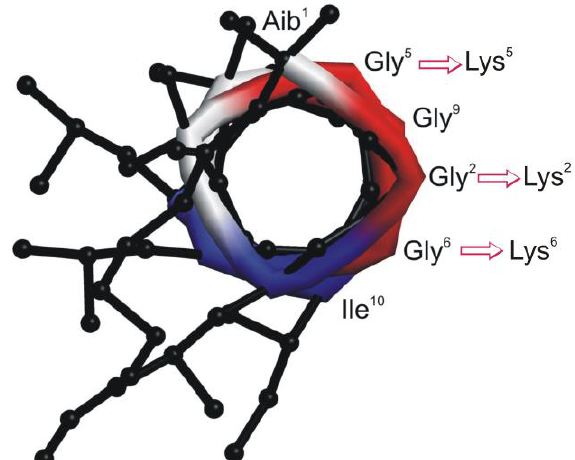
Figure 1. Helical structure of the native peptaibol trichogin (view along the helical axis) [27]. Substitutions of Lys for Gly were made on the less hydrophilic